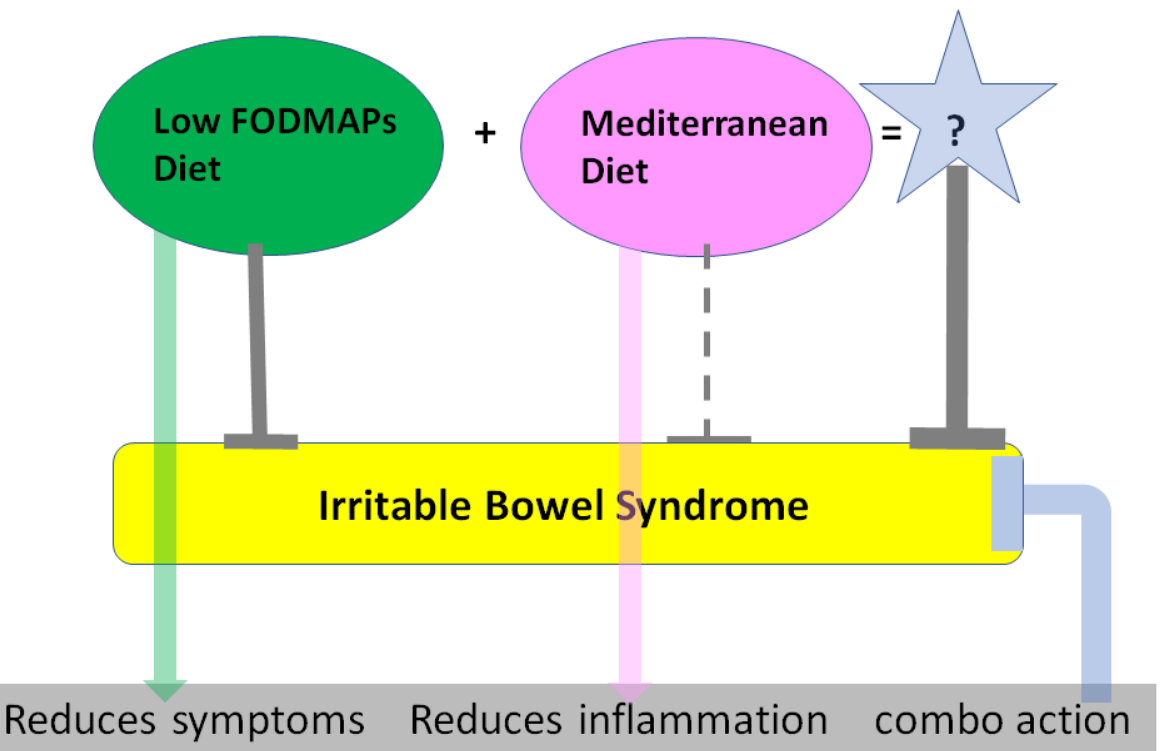
Figure 1. Schematic presentation of the hypothesis of combining the Mediterranean diet with the low ‐ FODMAP diet for the management of irritable bowel syndrome.